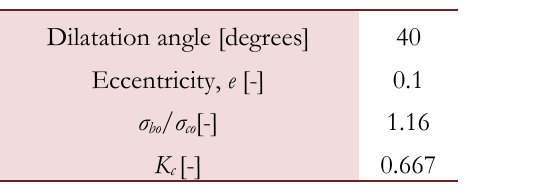
Table 3: The constitutive parameters of CDP model.